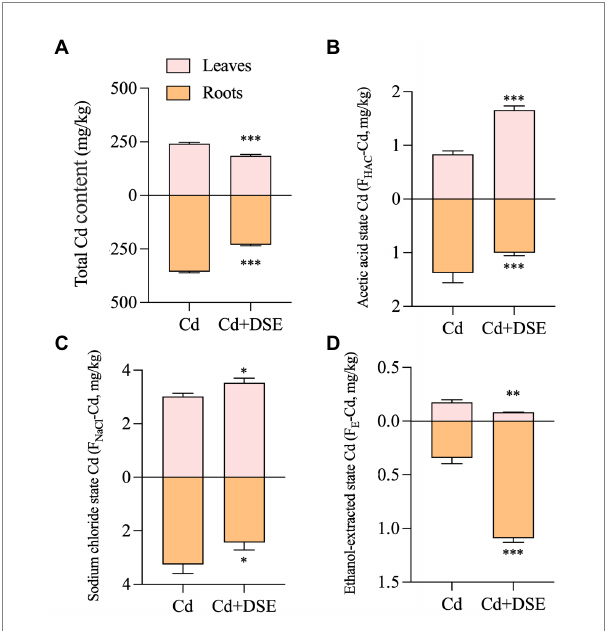
FIGURE 2 Responses of Cd accumulation (A) and chemical forms, including acetic acid state Cd (B) , sodium chloride state Cd (C) and ethanol- extracted state Cd (D) of maize to E. pisciphila inoculation. Data were mean values ( n = 3) and error bars represent the standard deviation. “NS,” “*,” “**,” and “***” mean no significance, p < 0.05, p < 0.01, and p < 0.001,